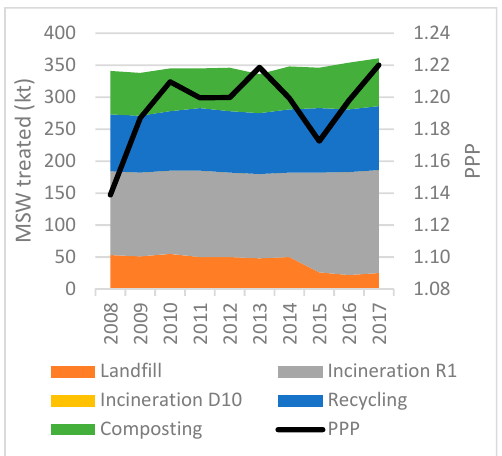
Figure 32. Waste treatment method and PPP in Luxembourg 2008–2017 (European Statistics 2019b, 2019c).